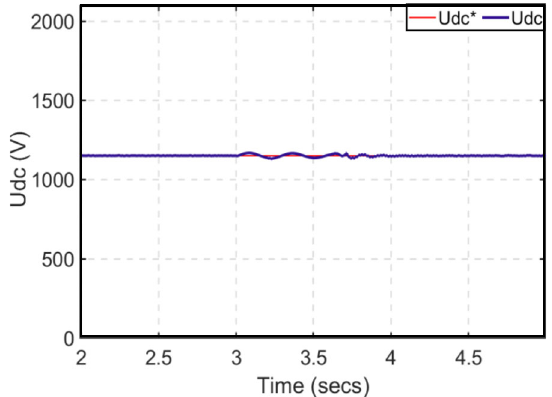
Fig. 23 Evolution of the stator reactive power Fig. 24 Evolution of the DC bus